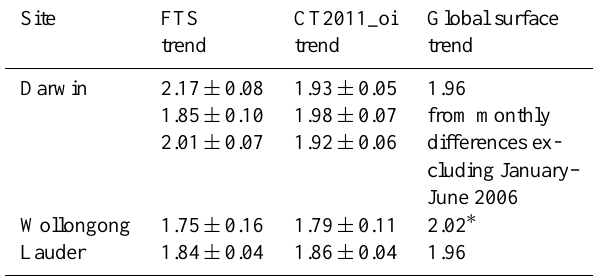
. All values are given 2